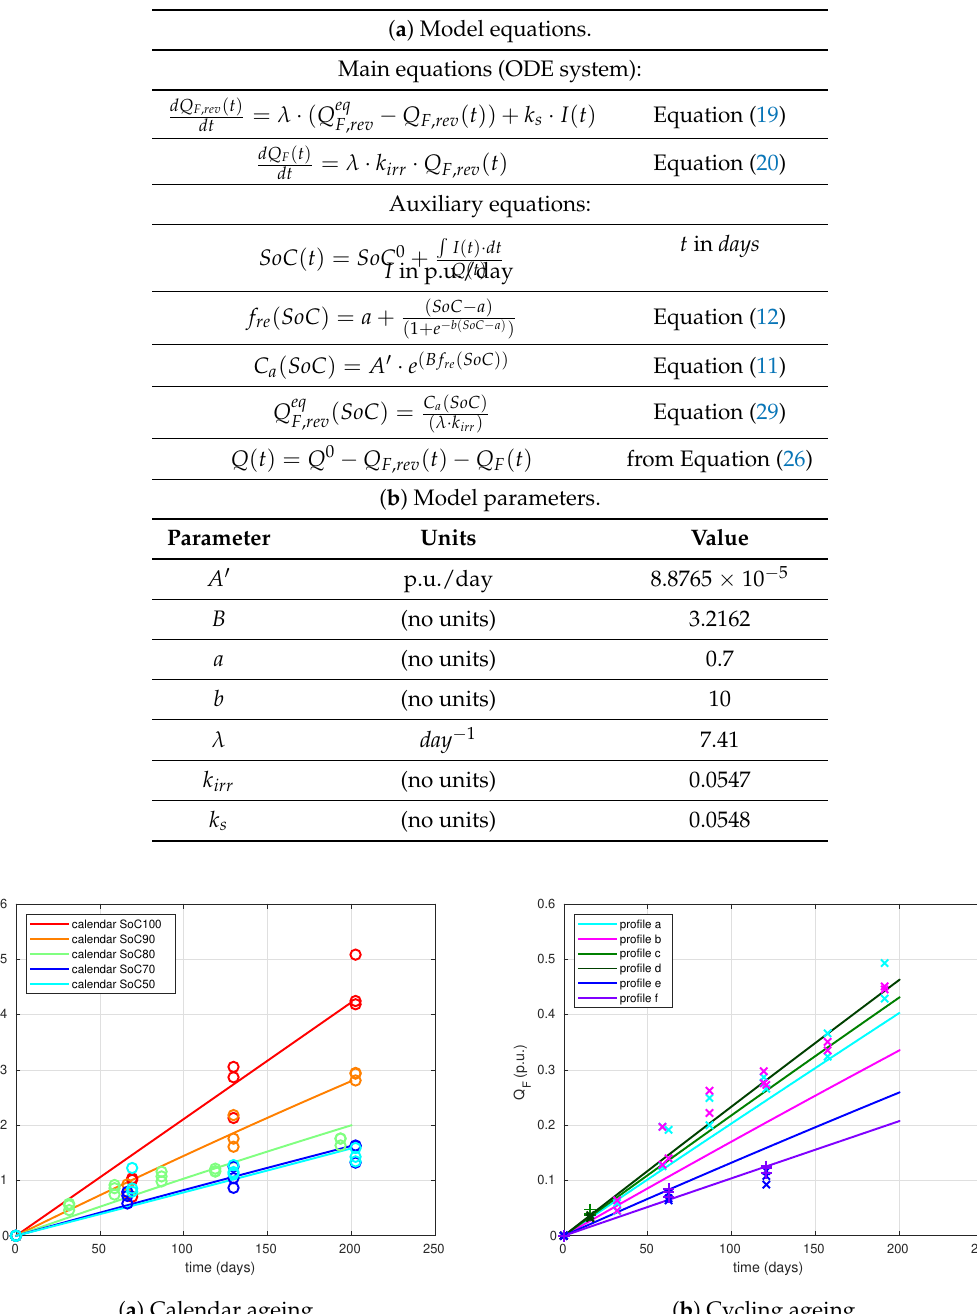
Table 3. Summary of model parameters and equations.